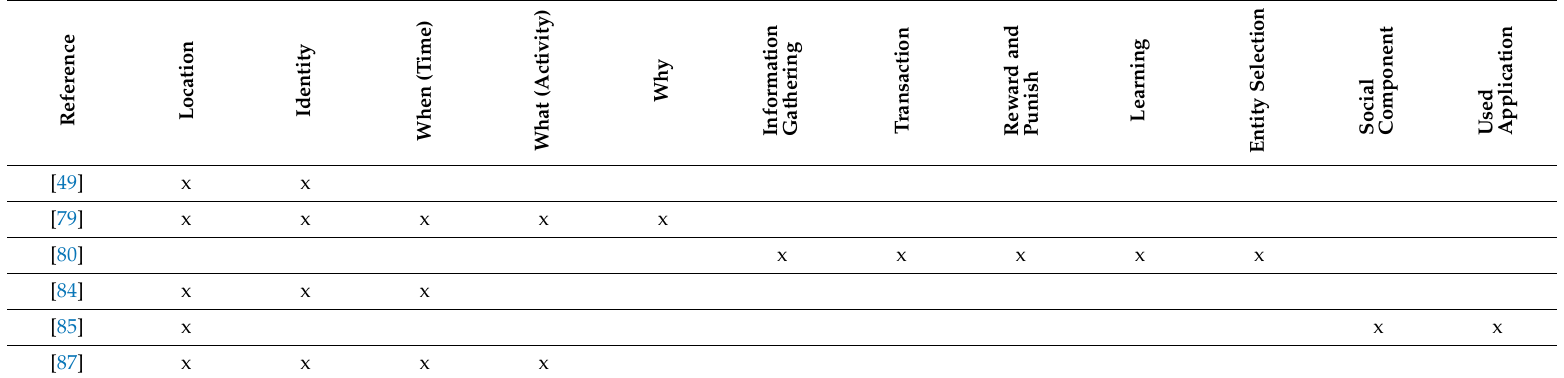
Table A6. The list of CIFs impacting security